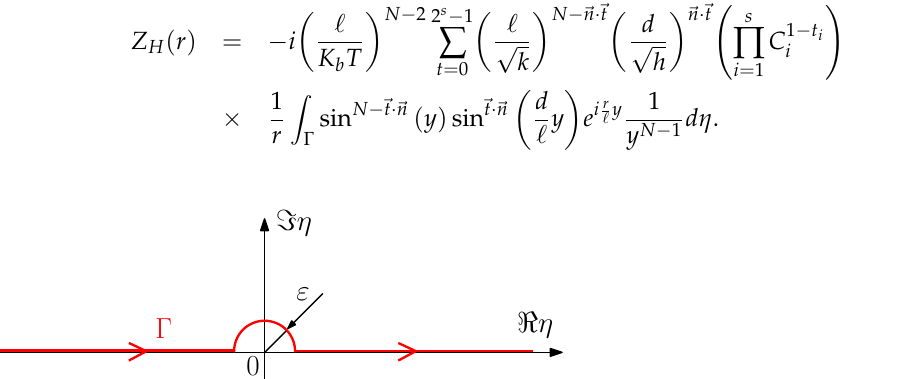
Figure 3. Definition of the contour Γ on the complex